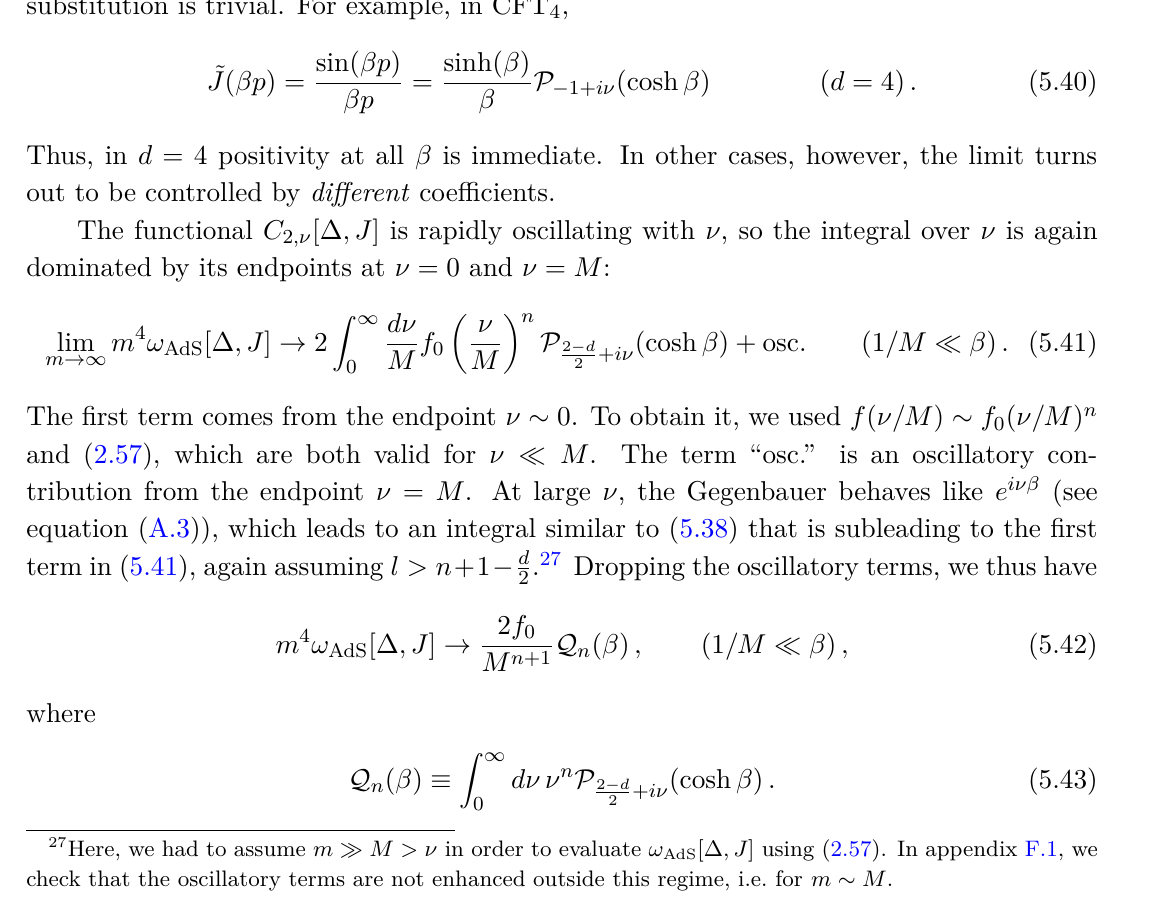
Figure 16. The function β n +1 ( sinh β everywhere positive and smoothly interpolates between the limits